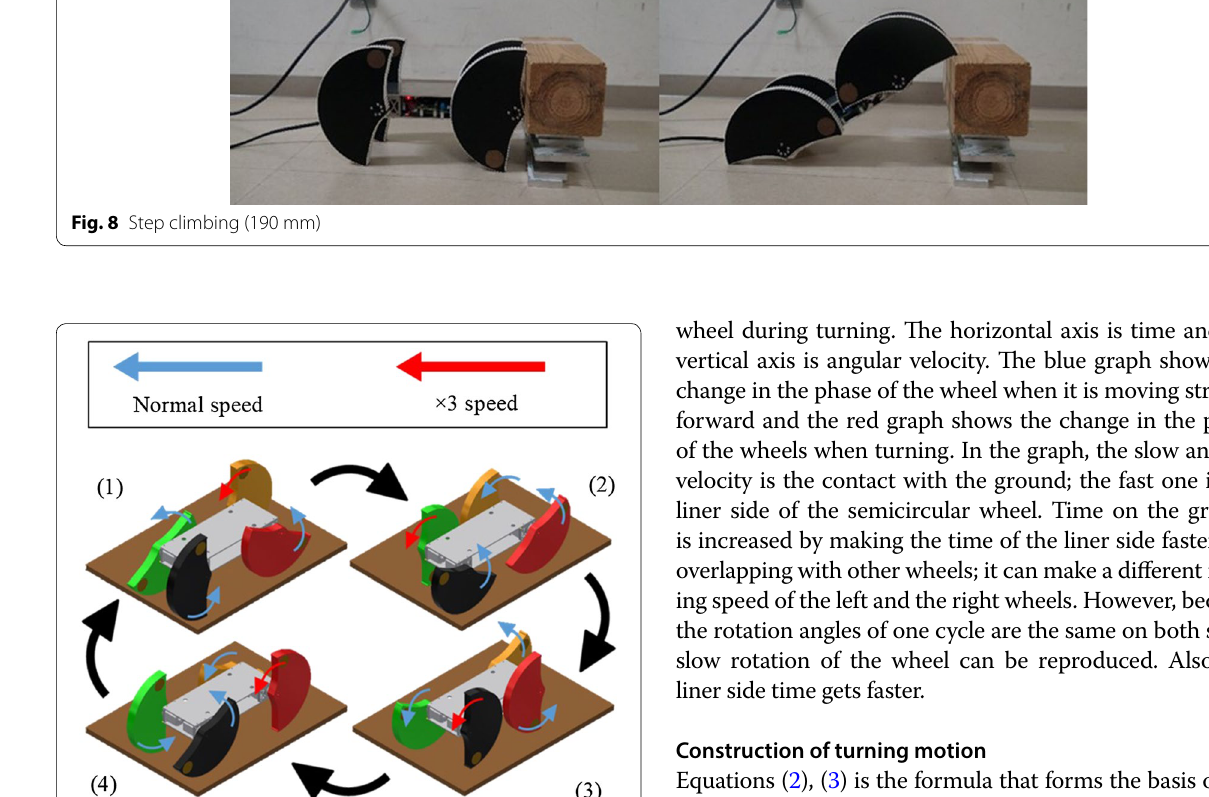
Fig. 9 Phase change of crawl